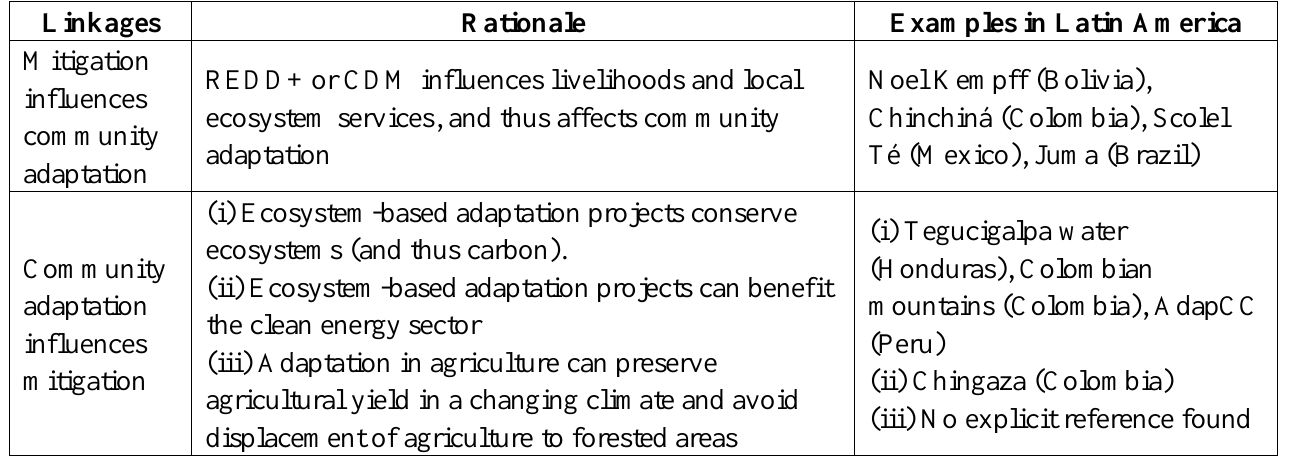
Table 5. Linkages between mitigation and community